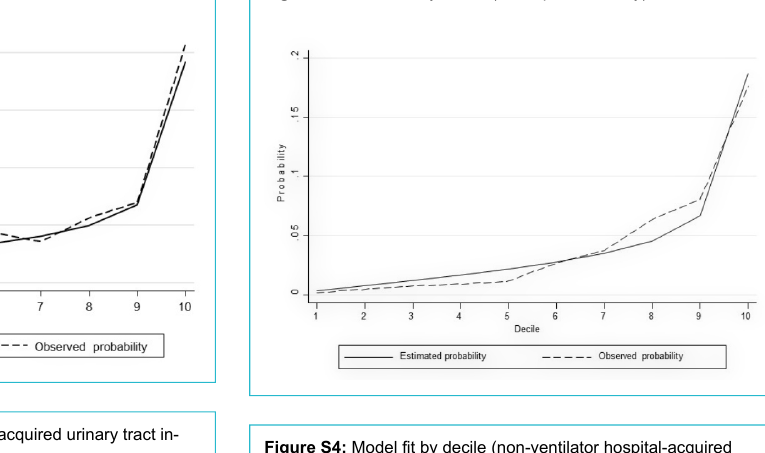
Figure S4: Model fit by decile (non-ventilator hospital-acquired